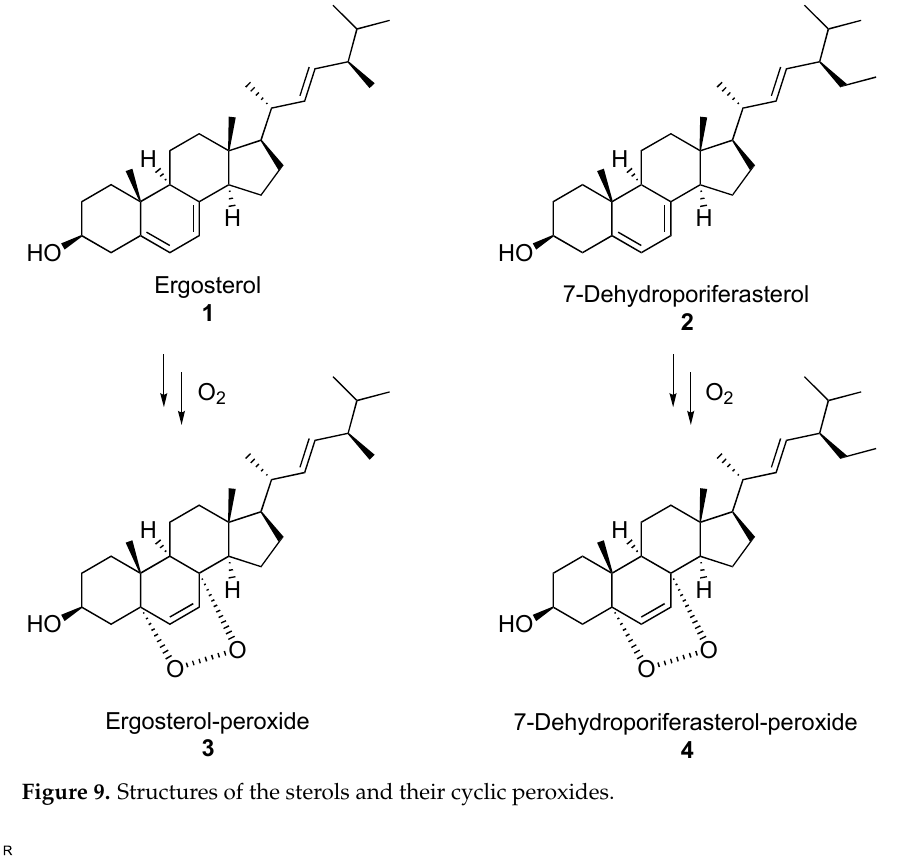
Figure 8. LC ‐ UV ‐ MS chromatograms of Chlorogonium (left panel), S. polymorphus cells (central panel) and the S. polymorphus extrusomes discharge (right panel) extracts. UV chromatograms are dis ‐ played for ergosterol 1 and 7 ‐ dehydroporiferasterol 2 (280 nm), while EIC traces are displayed for the oxidized analogues 3 and 4 (429.3 and 443.3 m / z , respectively).